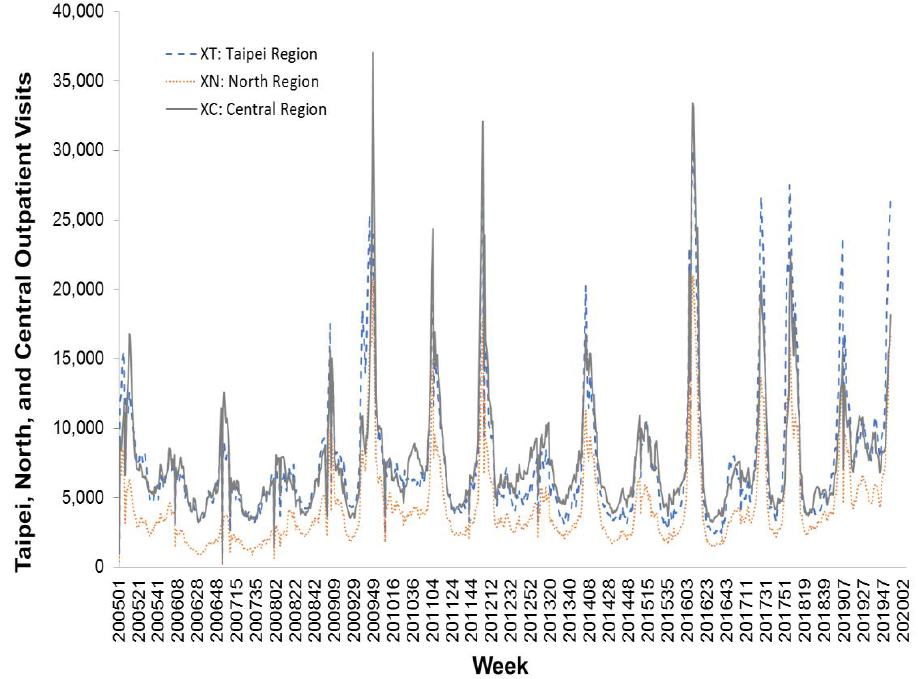
Figure 3. The influenza outpatient visits for Taipei, North, and Central regions in Taiwan from the first week of 2005 to the second week of 2020.